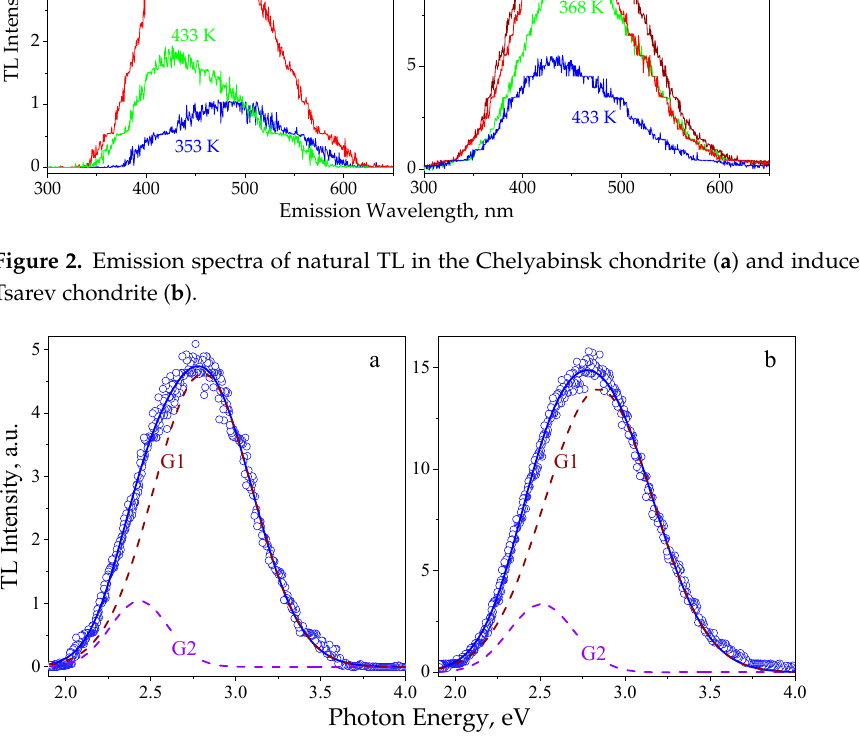
Figure 3. Deconvolution of TL spectra measured at 393 K for the Chelyabinsk ( a ) and Tsarev ( b ) chondrites. For both plots: circles—experimental data; colored dashed lines—the corresponding Gaussian components; and solid blue lines—resulting approximation curves.